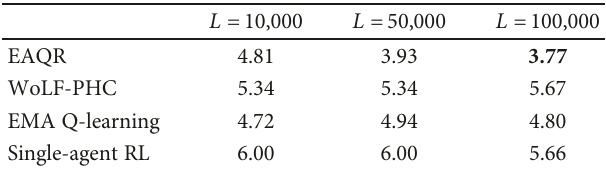
Table 8: Maximal steps for the DSN problem